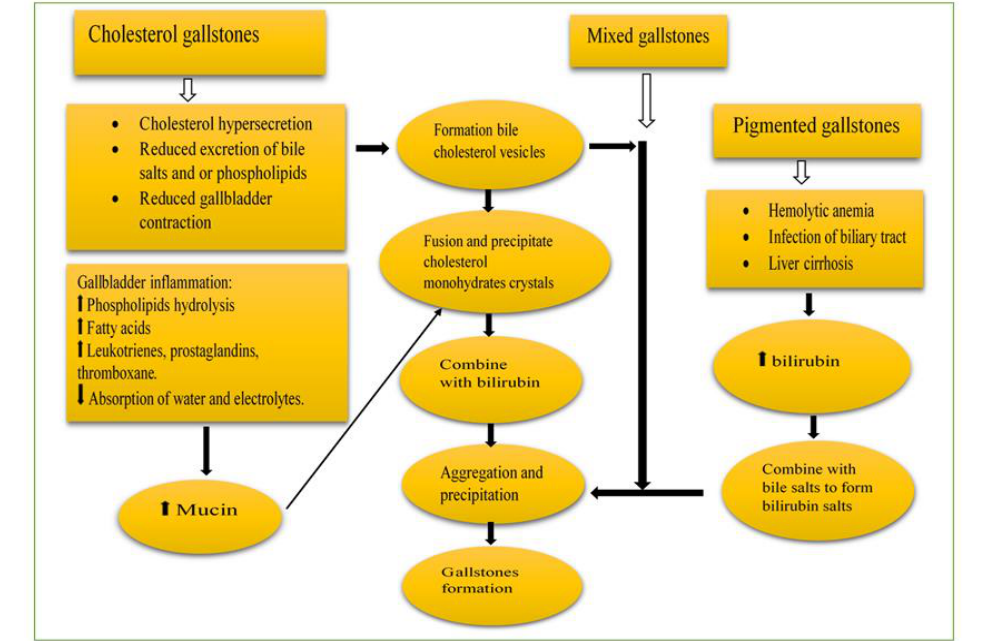
Fig. 2: the pathogenesis of cholesterol, pigmented and mixed